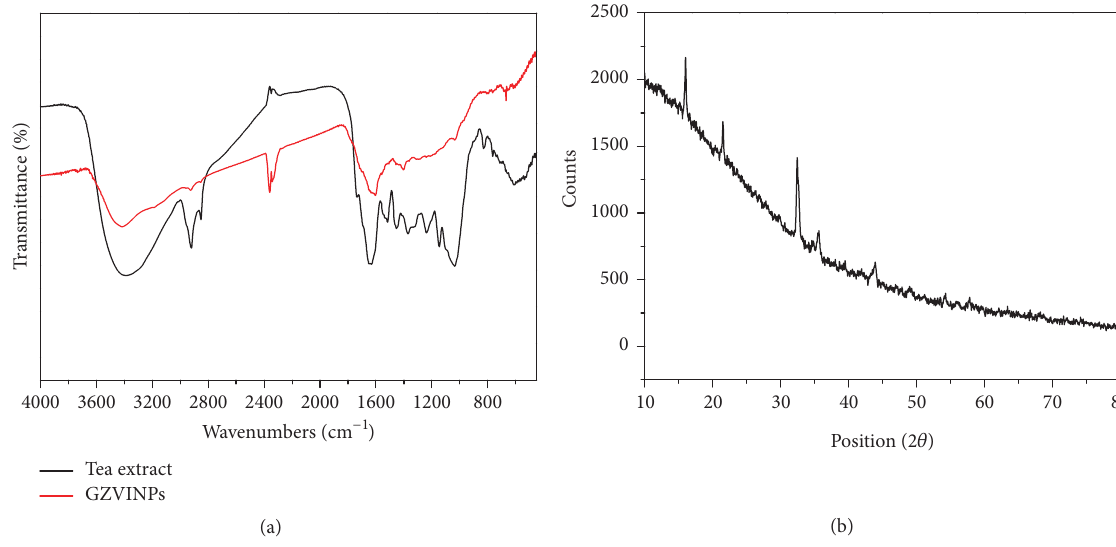
Figure 3: FTIR spectrum (a) and XRD pattern of GZVINPs synthesized with Tie Guanyin tea extract (b).